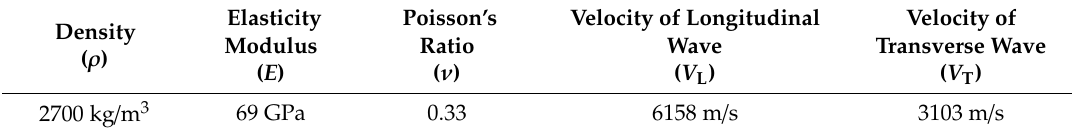
Table 1. Material parameters of the aluminum used in finite element (FE) simulations.